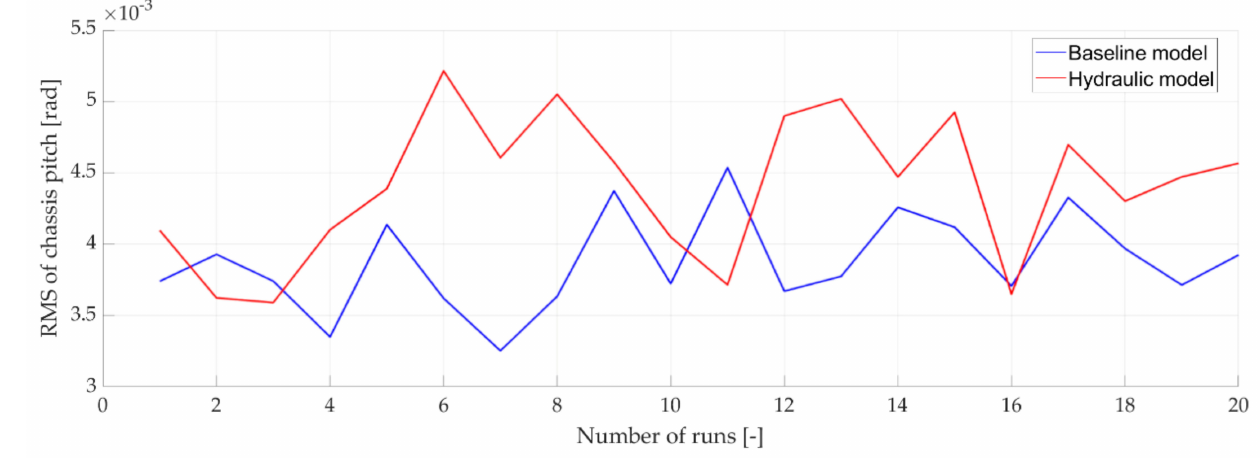
Figure 19. Chassis pitch root mean square for a realistic road profile.